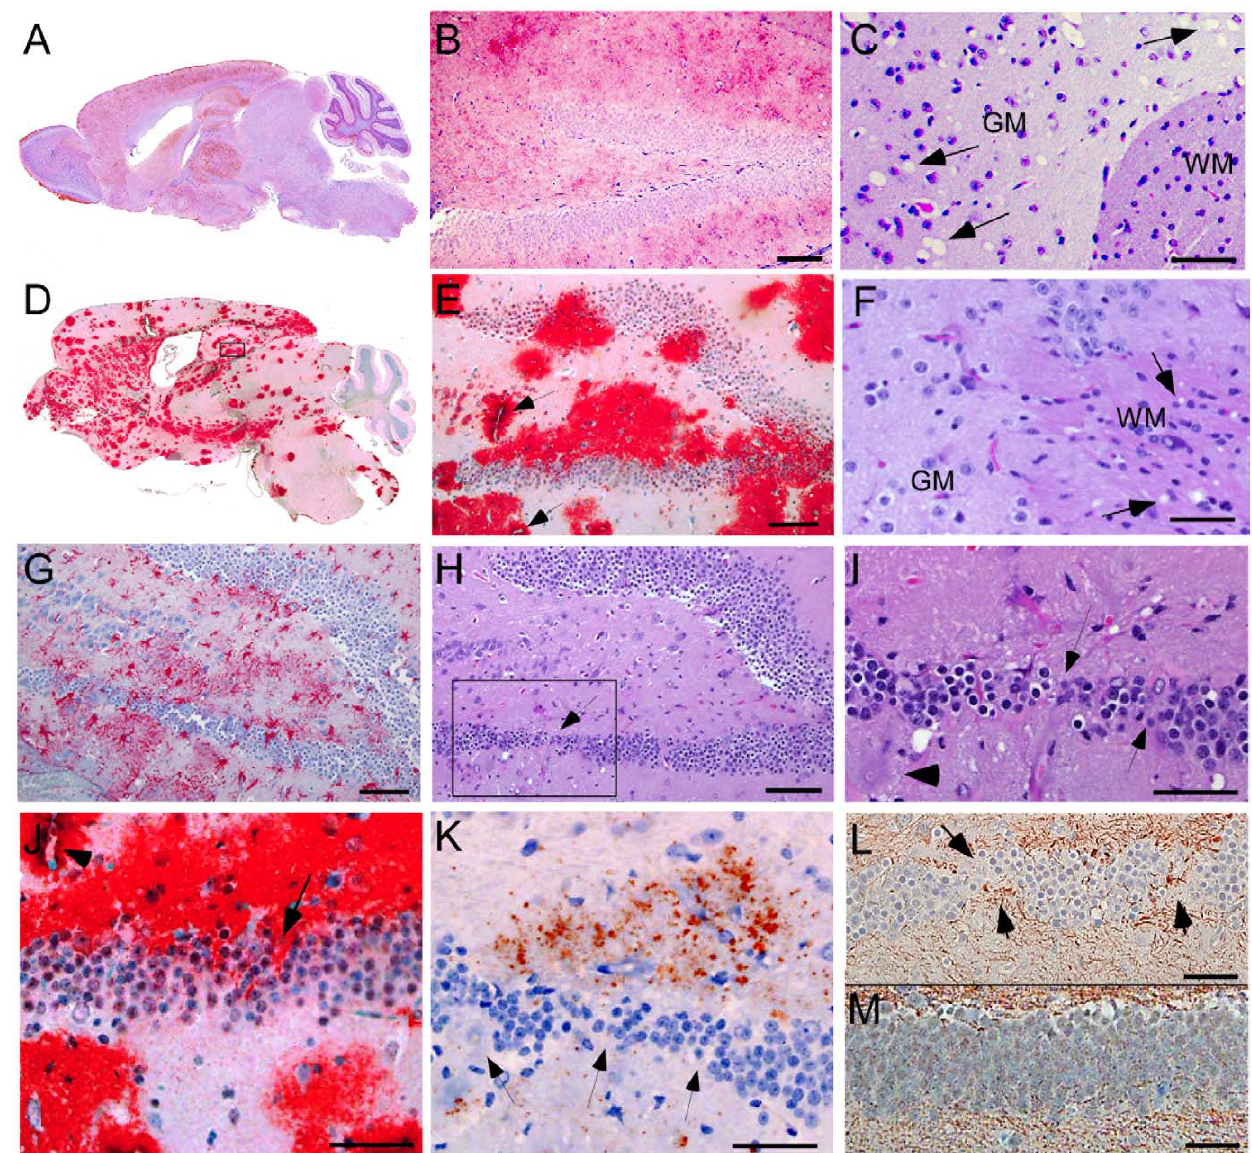
Figure 4. Light microscopic histopathology of scrapie-infected C57BL/10 and tg44 + / + transgenic mice. (A) Whole brain sagittal section of C57BL/10 mouse infected IV with RML scrapie at 180 dpi showing wide distribution of diffuse PrPres stained with monoclonal antibody D13. (B) High power view of C57BL/10 mouse infected IC with RML scrapie at 157 dpi showing diffuse punctuate pattern of PrPres in hippocampus. (C) H&E stain of forebrain of C57BL/10 mouse infected IP with 22L scrapie at 375 dpi. Anterior commissure white matter (WM) is seen in lower right. Numerous scrapie vacuoles (arrows) are visible in surrounding gray matter(GM). (D) Whole brain saggital section of tg44 + / + mouse D554 infected IC with RML scrapie showing dense plaque-like PrPres stained with monoclonal antibody D13 at 341 dpi. PrPres was found in most CNS areas including cerebral cortex, corpus callosum, forebrain, hippocampus, thalamus, hypothalamus, midbrain, colliculi, brainstem, and spinal cord. Cerebellar involvement was minimal after RML infection, as shown in panel 4D, but was strong in cerebellar molecular layer, granular layer and meninges after 22L infection (not shown). (E) Higher power of panel D shows large dense PrP plaques surrounding dentate gyrus of hippocampus often in a perivascular distribution (arrows). Note difference compared to diffuse PrPres staining in panel B. (F) H&E stain of mouse D554 showing vacuoles in the white matter (WM) near the anterior commissure and no vacuoles in surrounding gray matter, i.e. opposite distribution of vacuoles compared to C57BL/10 mouse in panel C. (G) Astrogliosis seen by staining with anti-GFAP in dentate gyrus of mouse D554. (H) H&E stain of dentate gyrus of mouse D554 shows marked neuronal loss in lower arm of gyrus (box and arrow). Boxed outlines region shown in panel I. (I) High power view of lower arm of dentate gyrus outlined in panel H, shows multiple areas of neuronal loss (arrows). Plaques surround this area and one plaque is indicated with the arrowhead at the left. (J) High power view of area shown in panel I shows D13 staining of PrPres plaques impinging on damaged neurons of the dentate gyrus (arrow). Arrowhead shows plaque around blood vessel in upper left corner. (K) Deposition of amyloid precursor protein, APP, (red- brown stain) adjacent to area of neuronal loss (arrows) in dentate gyrus of same area shown in panels I and J. (L) Abnormal axonal proliferation shown by staining with anti-neurofilament protein in area of neuronal loss (arrows) in dentate gyrus of mouse D554. (M) Anti- neurofilament pro- tein staining of dentate gyrus of uninfected control mouse shows no neuronal damage or abnormal axonal staining within the gyrus. Scale bars in panels B, E, G, and H are 100 microns; all other scale bars are 50 microns. Similar pathological changes were seen at the time of clinical disease in both tg44 + / + and tg23 + / + mice infected with either 22L or RML strains of scrapie. D13 staining of PrPres in panels E and J was similar to results described previously in tg44 + / 2 and tg23 + / 2 mice at $ 498 dpi [19].